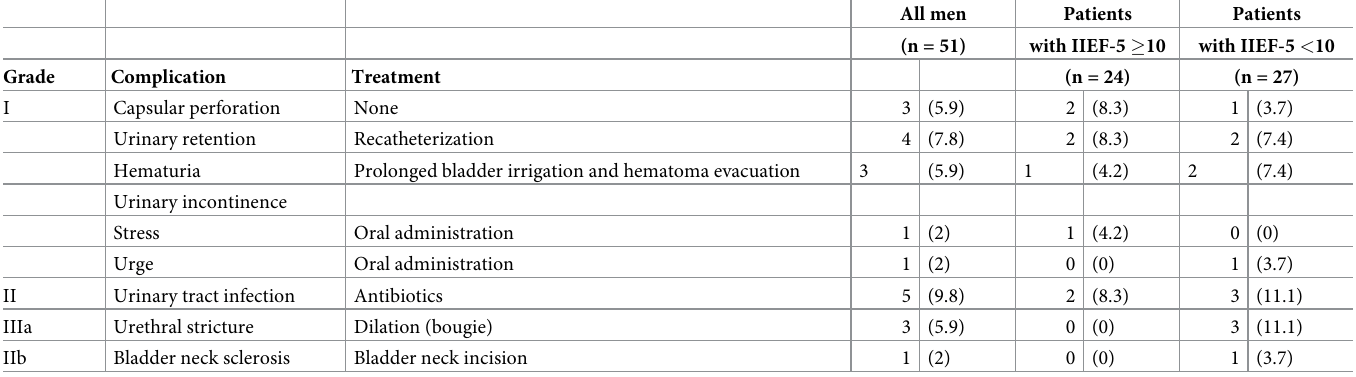
Table 3. Complications (Clavien-Dindo